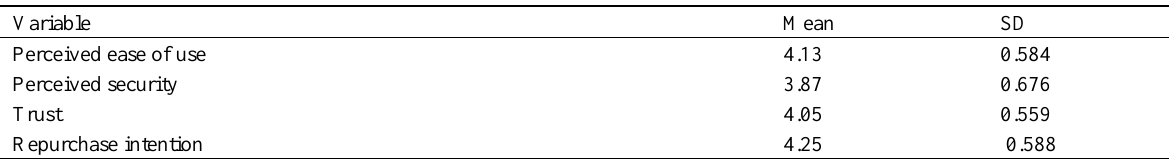
Table 2 : Descriptive Statistic and Correlation